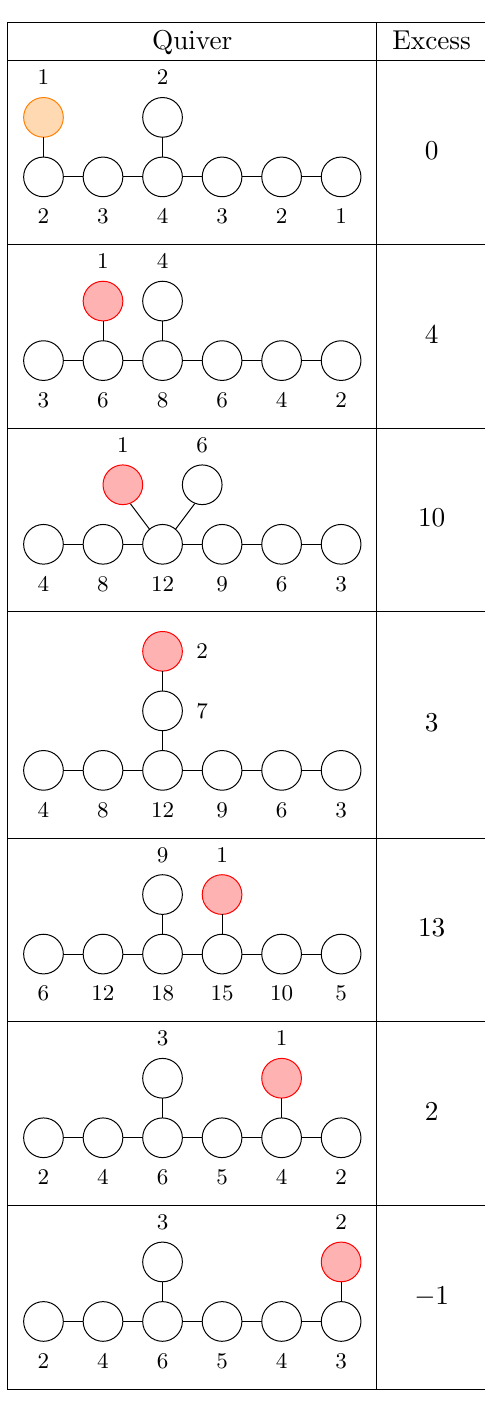
Table 5 . Minimally unbalanced quivers with G = E 7 .